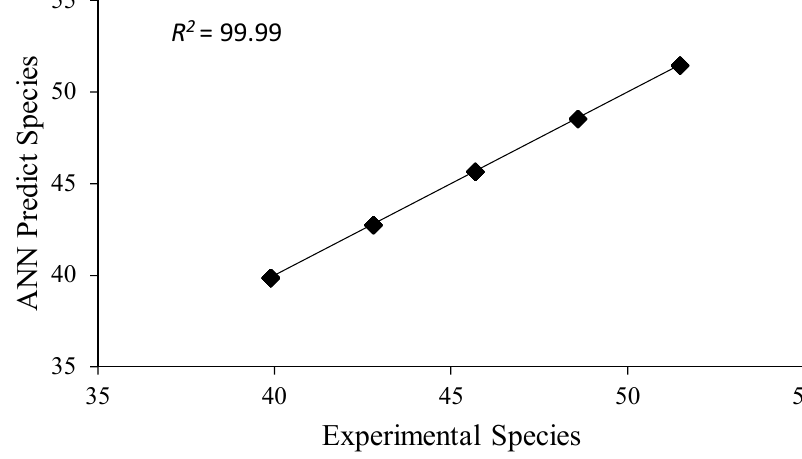
Figure 2. Regression graphics between ANN-predicted values and experimental data for species.